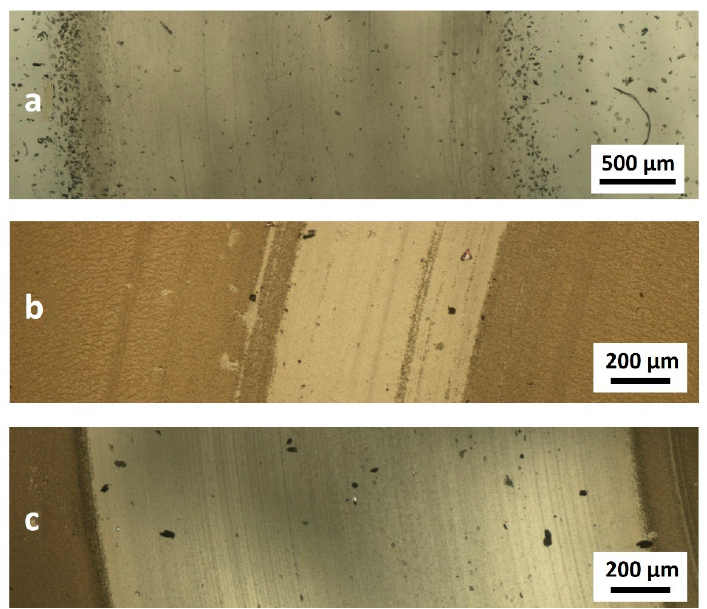
Figure 8. Sample forms of wear of the specimens after the tribological tests ( a ) for an unmodified PDMS specimen, ( b ) for a specimen modified through the RF PACVD 60 s/DLC process and ( c ) for a specimen modified with the DLC coating. specimen modified with the DLC